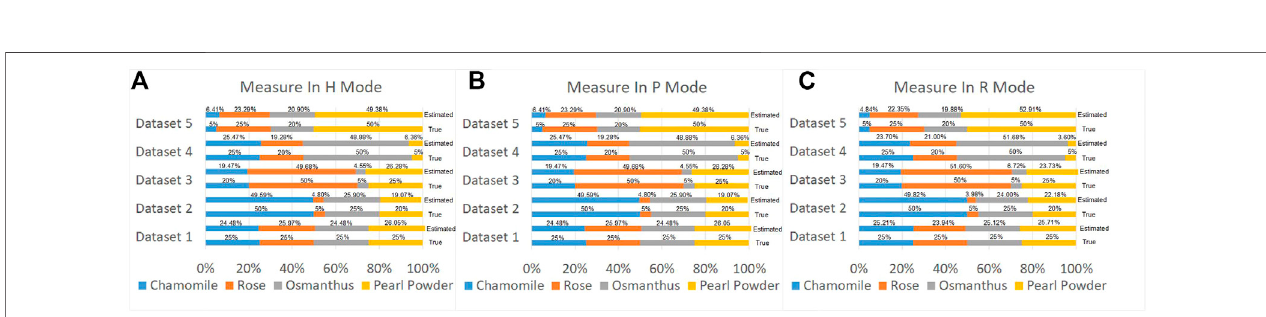
FIGURE 7 | True and predicted proportion of biological samples using MAPIS. (A) Measurement conducted in H mode; (B) Measurement conducted in P mode; (C) Measurement conducted in R mode.